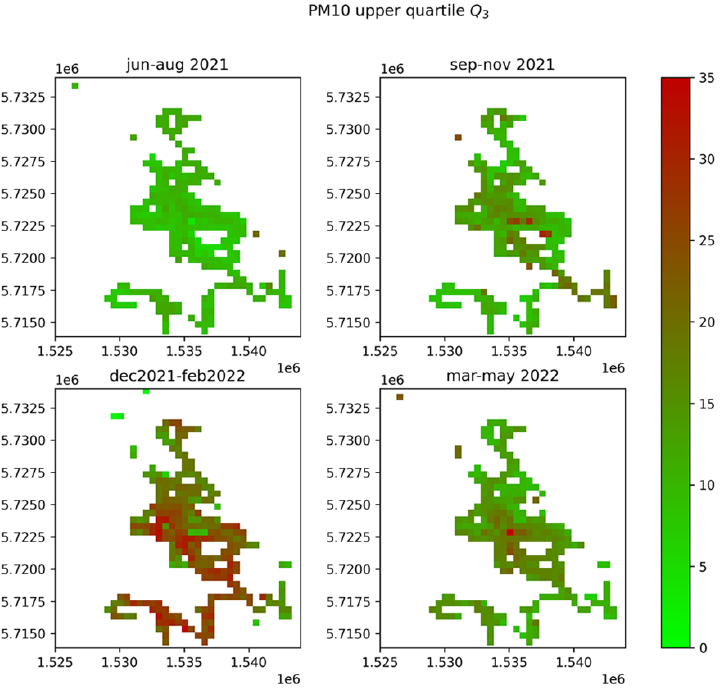
Figure 4. Comparison of third quartile distribution in the four seasons with the village of Opicina highlighted in light blue.